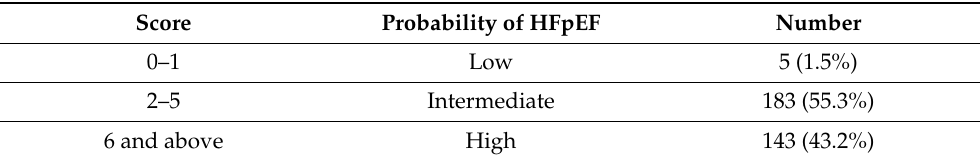
Table 3. H2FPEF score in patients diagnosed with HFpEF.